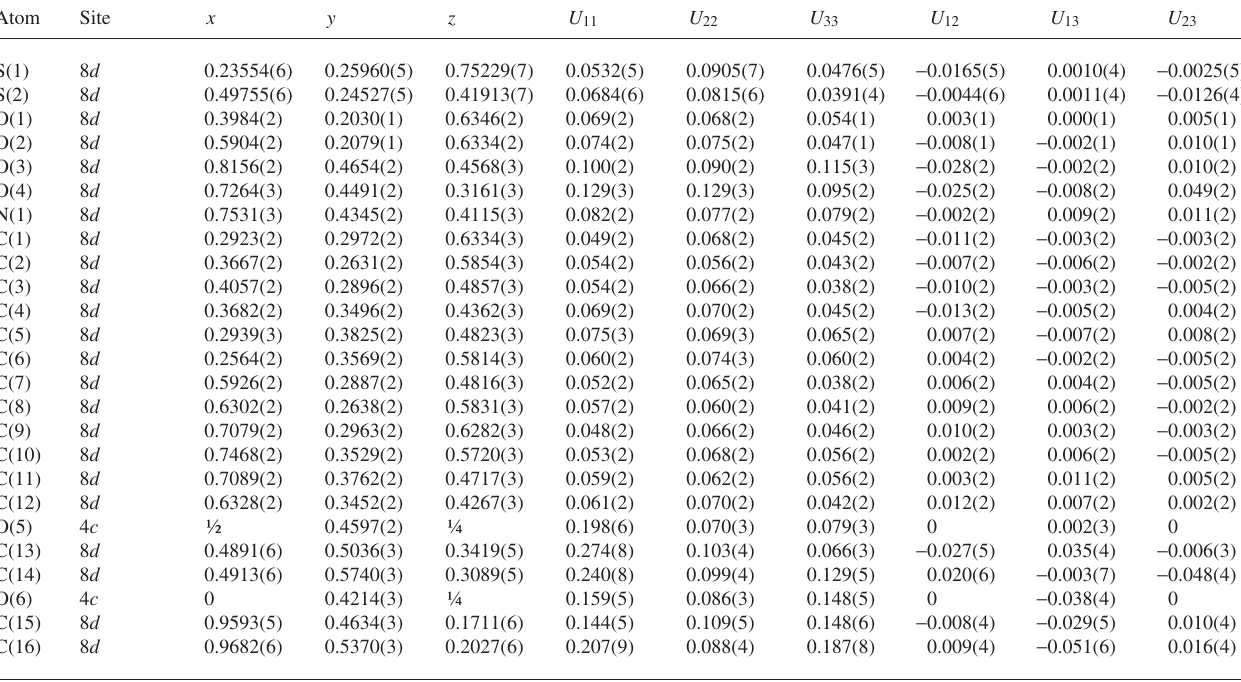
Table 3. Atomic coordinates and displacement parameters (in Å 2 )